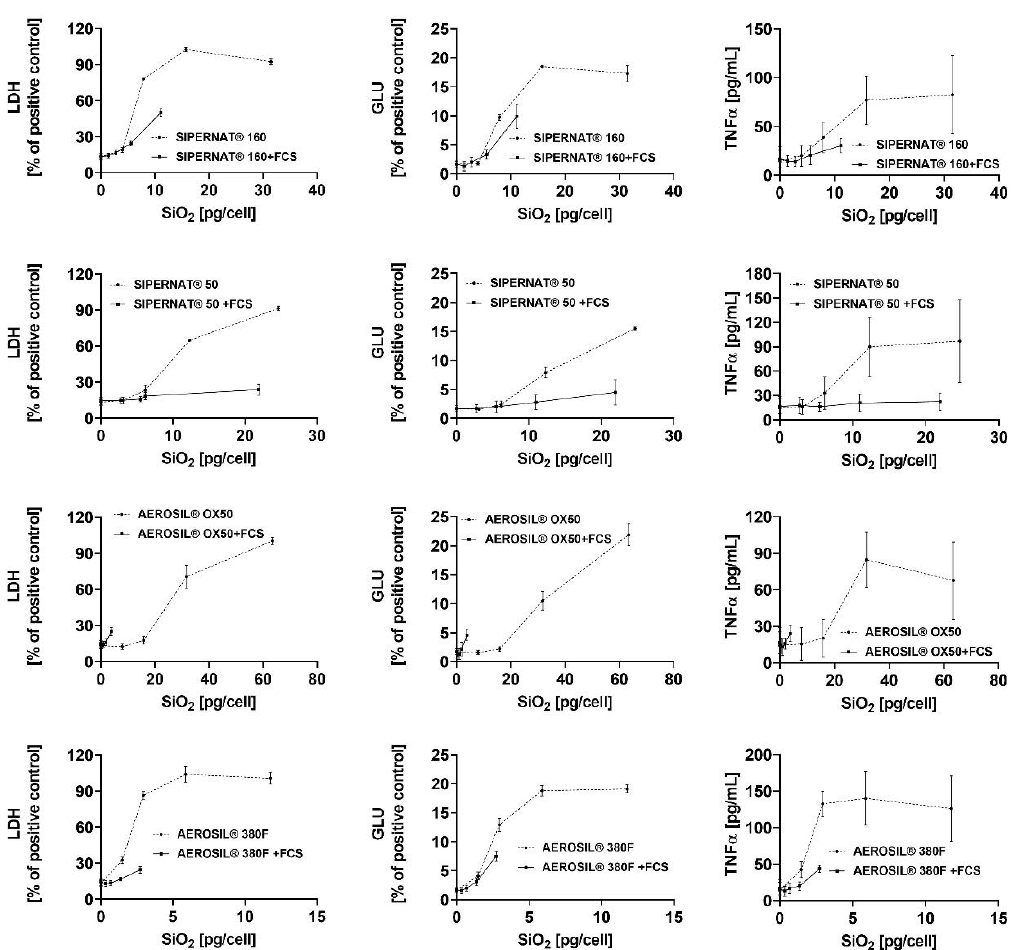
Figure 8. In vitro response of NR8383 alveolar macrophages to the cell-associated masses of SIPERNAT ® 160, SIPERNAT ® 50, AEROSIL ® OX50 and AEROSIL ® 380 F in the absence and presence of FCS. Values (from Table S1) for lactate dehydrogenase activity (LDH), glucuronidase activity (GLU), H 2 O 2 concentration, and tumour necrosis factor alpha (TNF α ) from were plotted against the cell-associated masses of SAS which were measured for a low SAS concentration and then extrapolated to higher values.